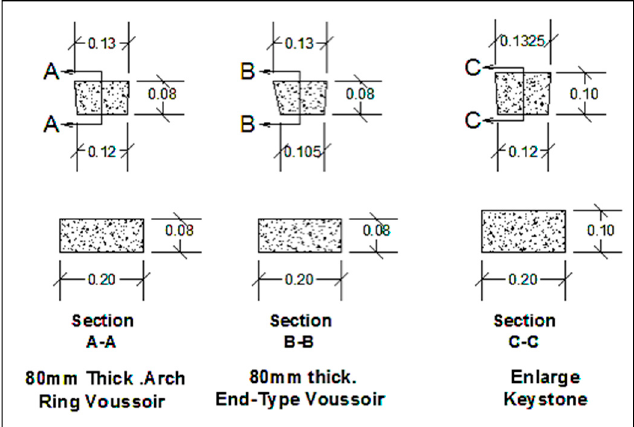
Figure 4. Wedge-shape voussoirs geometry.